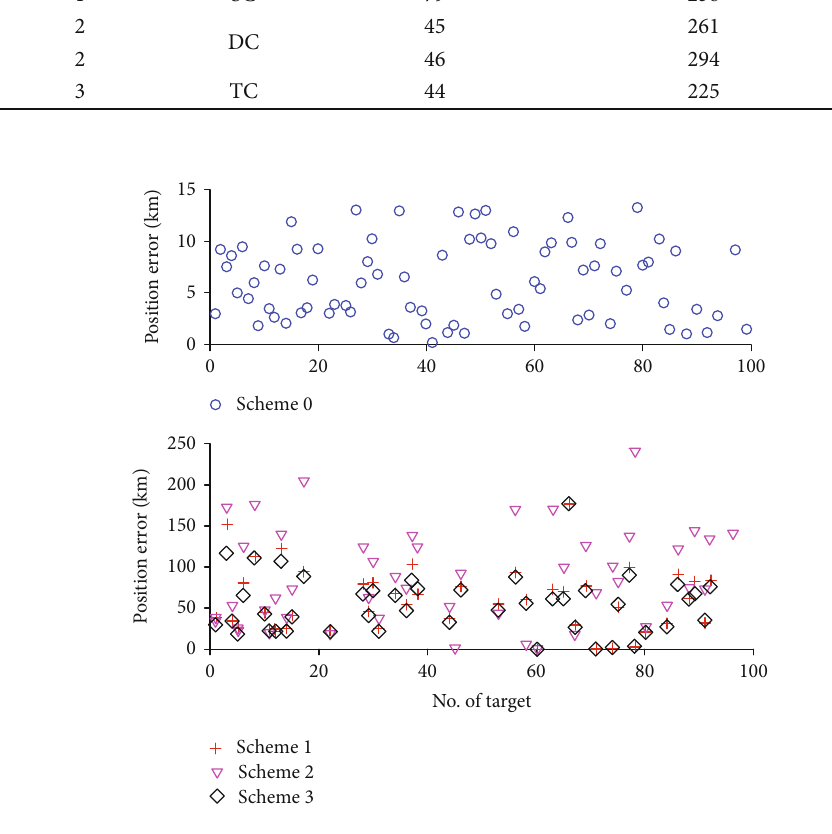
Figure 12: Position errors for di ff erence